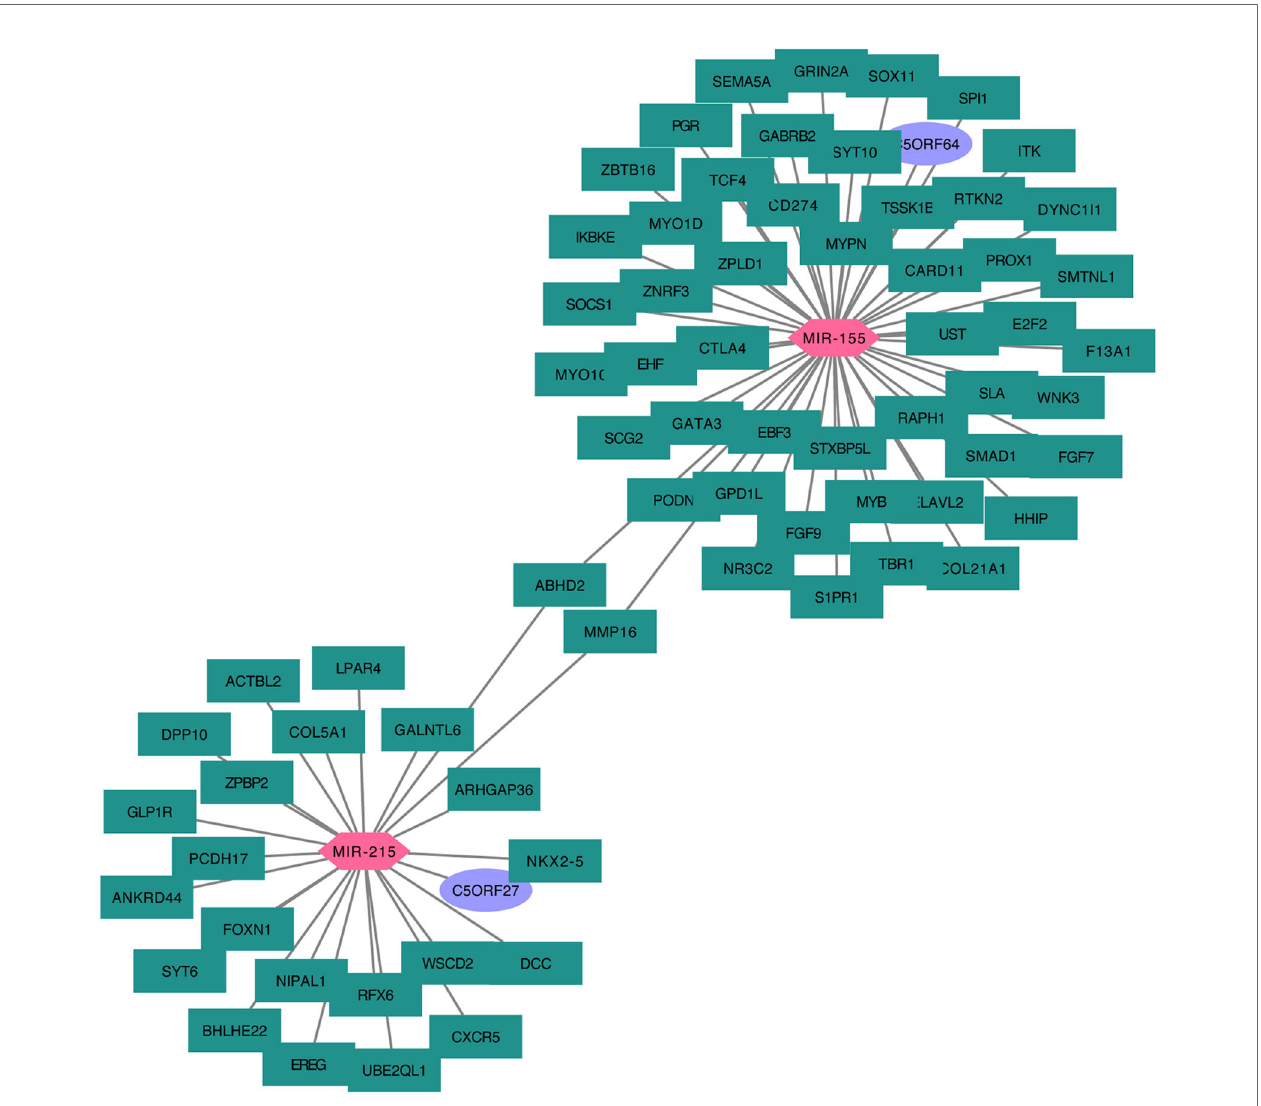
FIGURE 10 | Cytoskype network diagram of DEGs – miRNA –